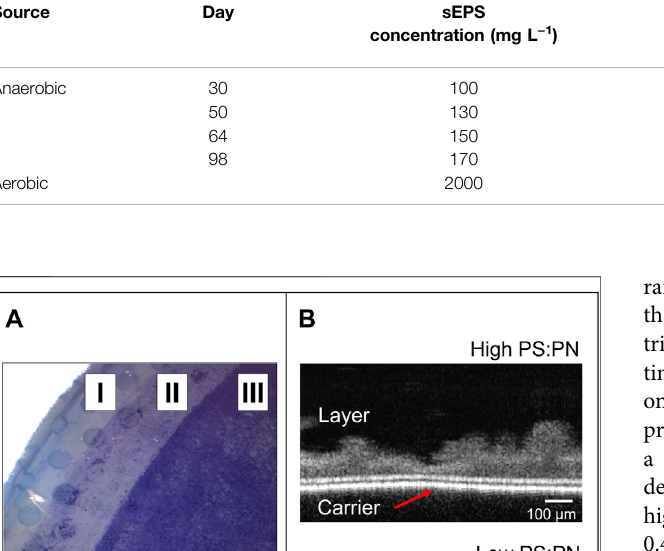
TABLE 1 | Anaerobic and aerobic sEPS concentrations, their polysaccharide (PS) and protein (PN) content, and their ratio (PS:PN ratio). Source